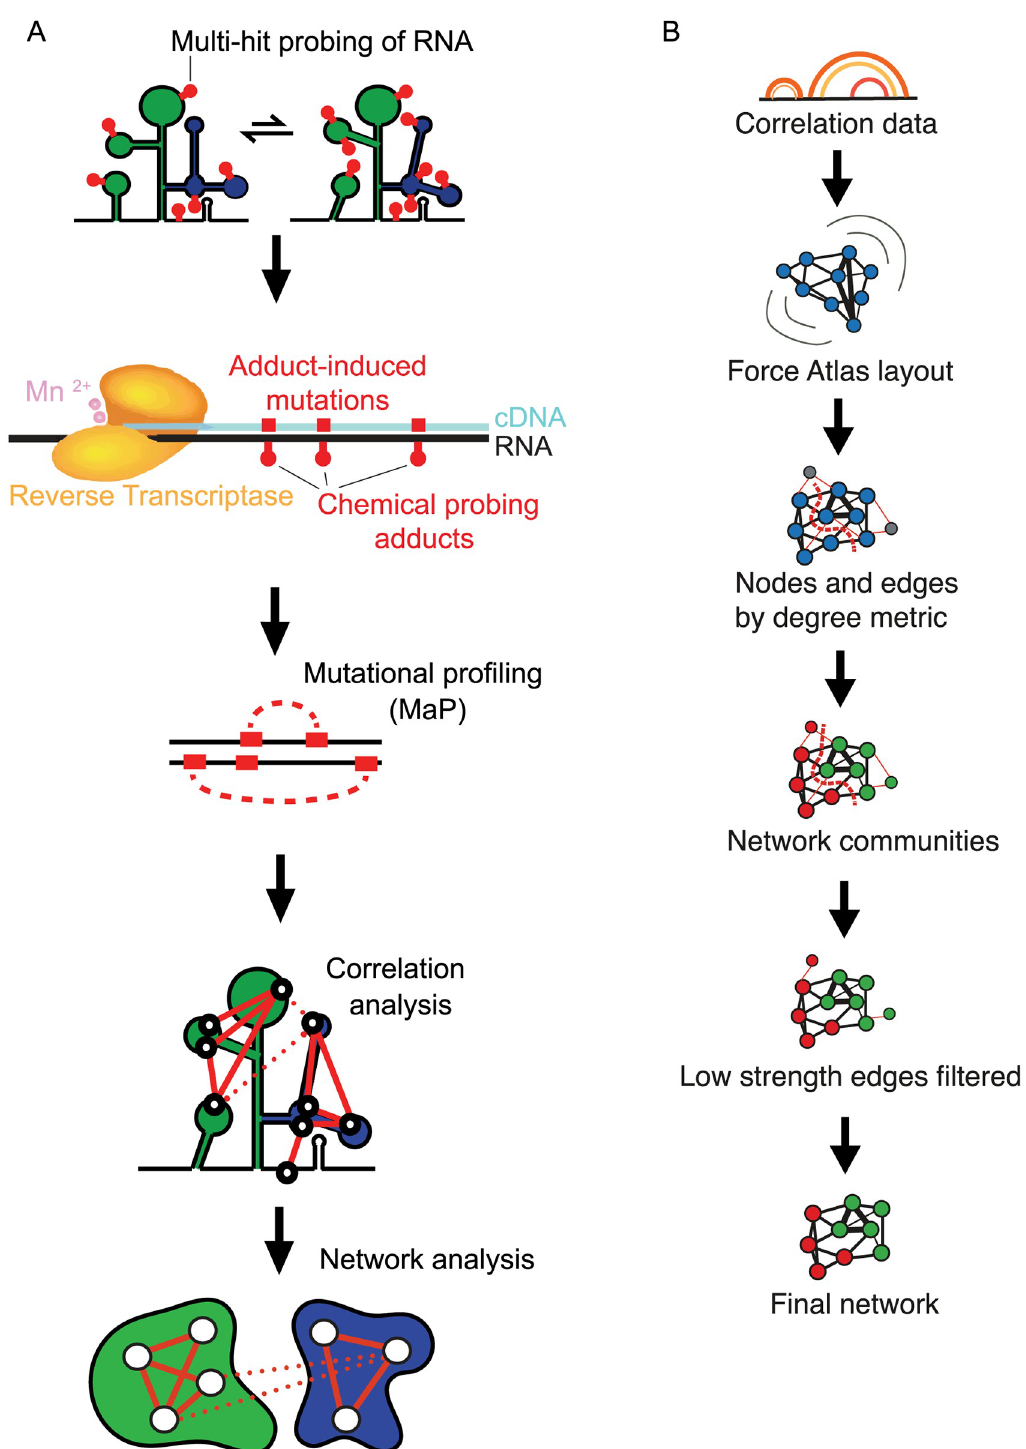
Fig 1. RING-MaP single-molecule correlated chemical probing and network analysis of a large RNA. (A) Overview of the RING-MaP experiment and network analysis. DMS chemical adducts on an RNA are detected by MaP, which records adduct sites as mutations and indels in the cDNA sequence generated by reverse transcription. Mutations co-occurring on the same read are analyzed for correlations that report RINGs, which are then visualized using a network graph. (B) Workflow for network analysis and detection of structural communities. Network analysis was performed using Gephi . DMS, dimethyl sulfate; MaP, mutational profiling; RING, RNA interaction group; RING-MaP, RNA interaction groups analyzed by mutational profiling.